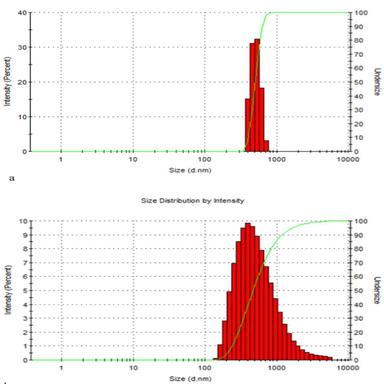
a Size distribution of PVPO measured by DLS. b Size distribution of HM measured by DLS.